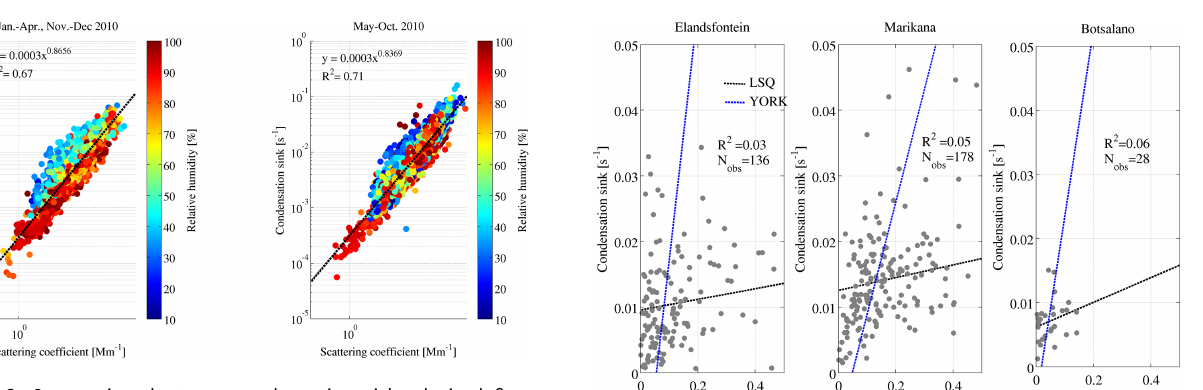
Figure 3. Comparison between condensation sinks derived from particle size distributions, as described in the text, and nephelometer scattering coefficients measured at Elandsfontein station in 2010 for the warm (January–April, November–December) and cold (May– October) seasons. CS has been corrected to the ambient relative hu- midity but the scattering coefficient was measured from dry parti- cles. The data are colour-coded according to ambient relative hu- midity, of which the strong influence on the relation between CS and scattering coefficient is evident.